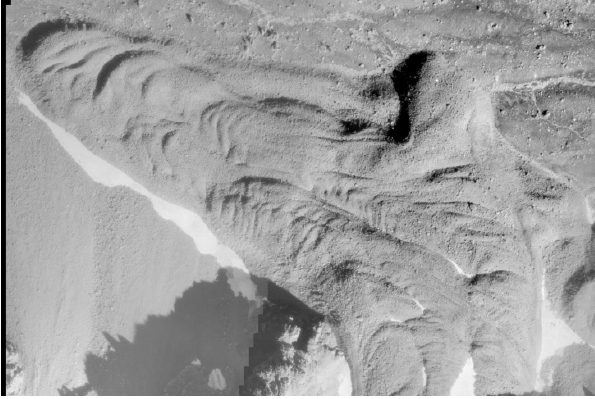
Figure 2. A section of the aerial photographic image (400 m × 600 m) over part of the Muragl rockglacier taken on 7 September 1981, North to the top.